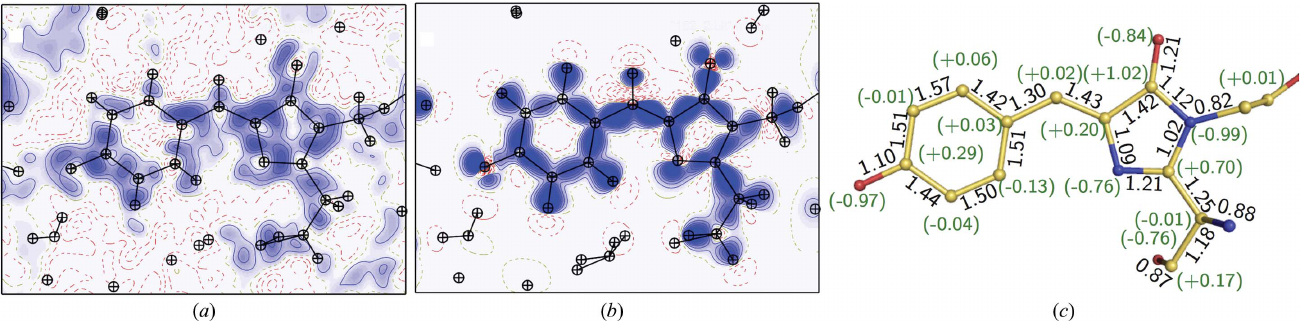
Figure 6 Charge-density analysis of the E222Q variant. ( a ) The residual density in a slice of the chromophore plane after ISAM refinement. ( b ) The static deformation density in a slice of the chromophore plane after MAM refinement. The contour intervals are 0.05 e A˚ (cid:5) 3 . Positive, blue lines; negative, red broken lines. The intervals are only colored in blue. ( c ) AIM charge values are shown in parentheses on each atom, while topological bond orders are given along each covalent bond. H atoms and their positive charges are not